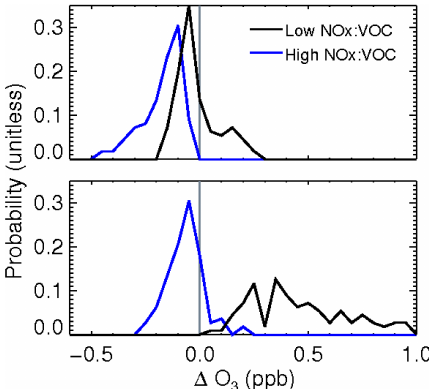
Figure 7. Probability distributions of the change in JJA mean sur- face O 3 concentrations as a result of tree mortality for grid boxes with low (<10th percentile) baseline NO x :VOC emission ratios and high (>10th percentile) baseline NO x :VOC emission ratios. Top: results from mortality-driven changes in emissions only (Sim- ulation 3 – Simulation 1). Bottom: results from mortality-driven changes in emissions and deposition combined (Simulation 4